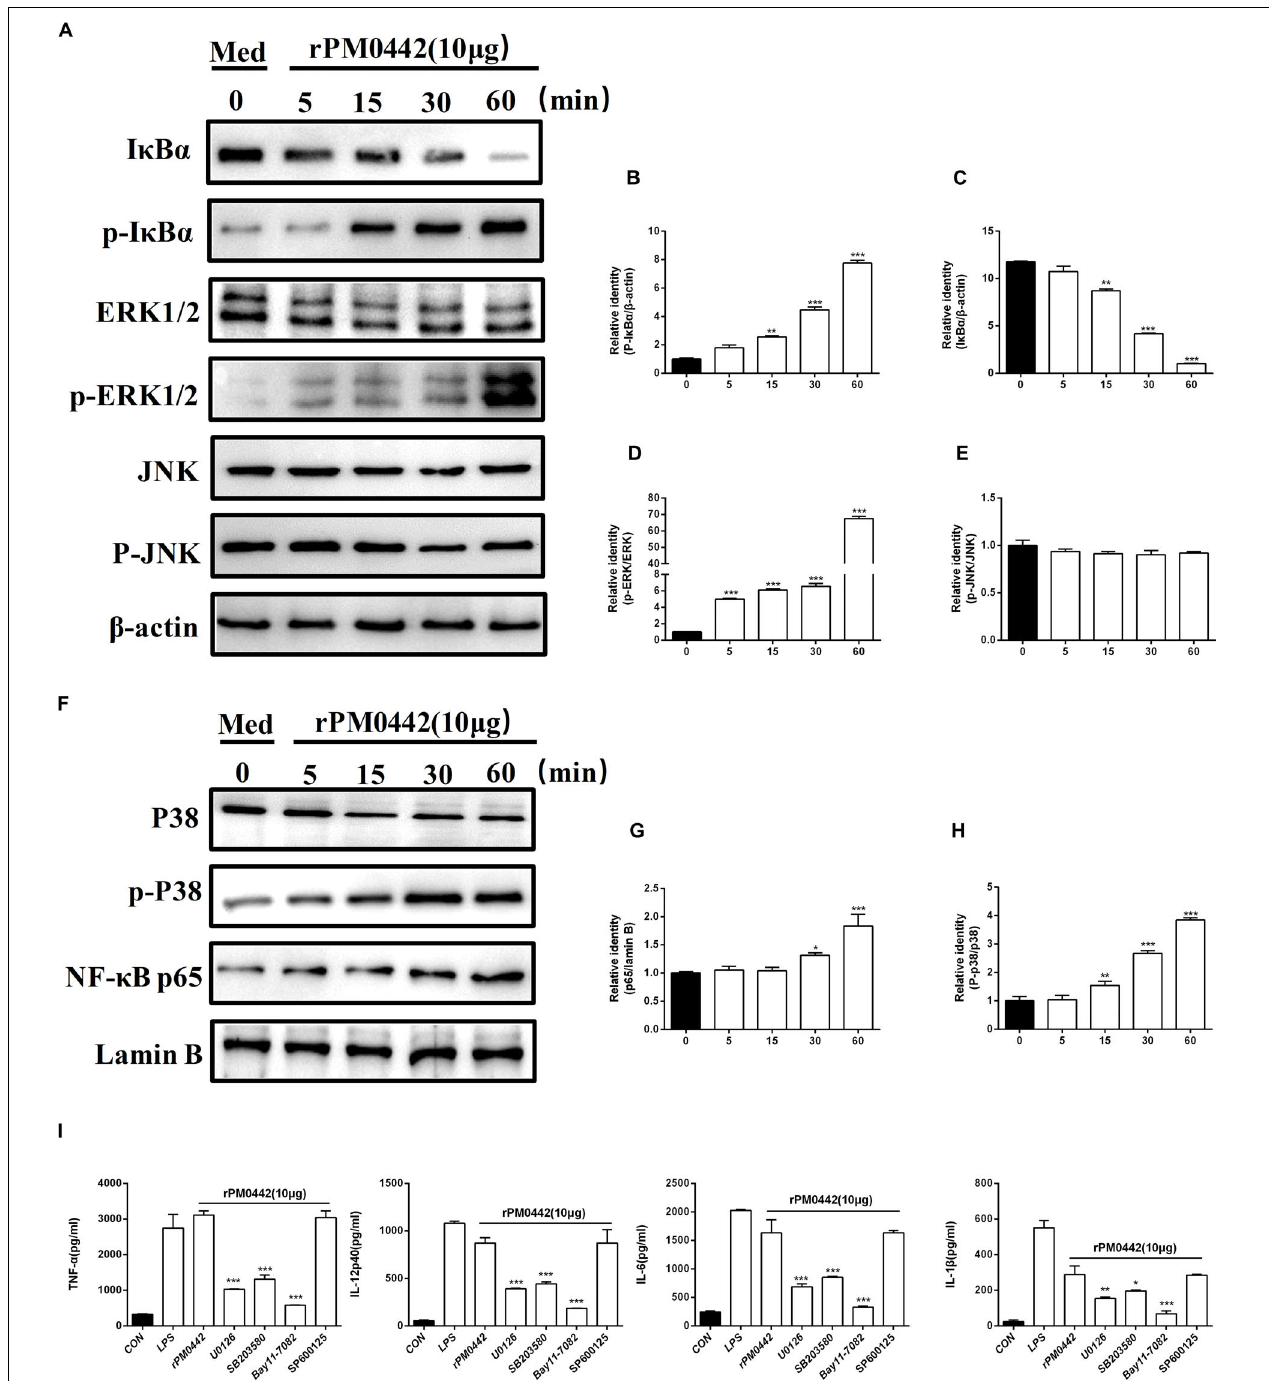
FIGURE 7 | PM0442 induces cytokine secretion dependent on NF-kB and MAPKs signaling pathways. (A–H) Peritoneal macrophage incubated with 10 µ g/mL rPM0442 protein for 0, 15, 30, or 60 min. Then, the cell lysates were collected, and the content of I κ B α , ERK, and JNK in cytoplasm and NF- κ B (p65) and P38 in nuclear, and total phosphorylated I κ B α , ERK and JNK levels were detected by western blotting with β -actin (in cytoplasm) and Lamin B (in nuclear) as a control. (I) Peritoneal macrophages incubated with 10 µ g/mL rPM0442 protein for 24 h, and then the supernatants were collected. The amounts of IL-1 β , TNF- α , IL-6, and IL-12p40 in the supernatants were determined by ELISA. All inhibitors were added to cultures 1 h before rPM0442 protein incubation. The targets and concentrations of the kinase inhibitors are as follows: U0126 (ERK inhibitor, 10 µ M), SB203580 (p38 inhibitor, 30 µ M), BAY11-7082 (NF- κ B inhibitor, 20 µ M) and SP600125 (JNK inhibitor, 10 µ M). Panels (A–H) were representative of two independent experiments with 4 replicates per group. Panel (I) was pooled from two independent experiments with 6 replicates per group. Panels (B–E,G–I) were determined by one-way ANOVA and expressed as means ± SD (* P < 0.05, ** P < 0.01, *** P <